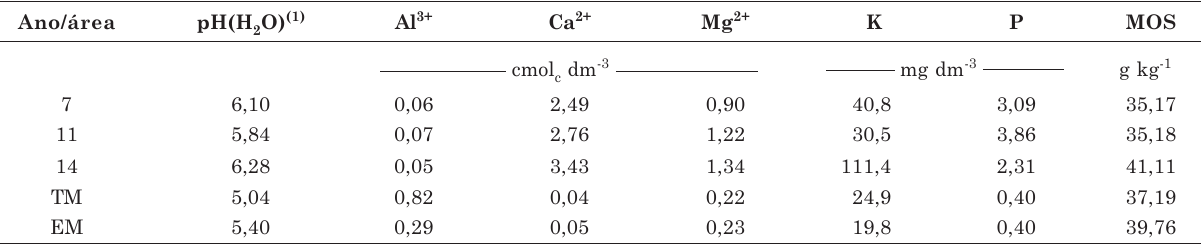
Quadro 2. Atributos químicos do solo das áreas agrícolas e do topo (MT) e entre os murundus